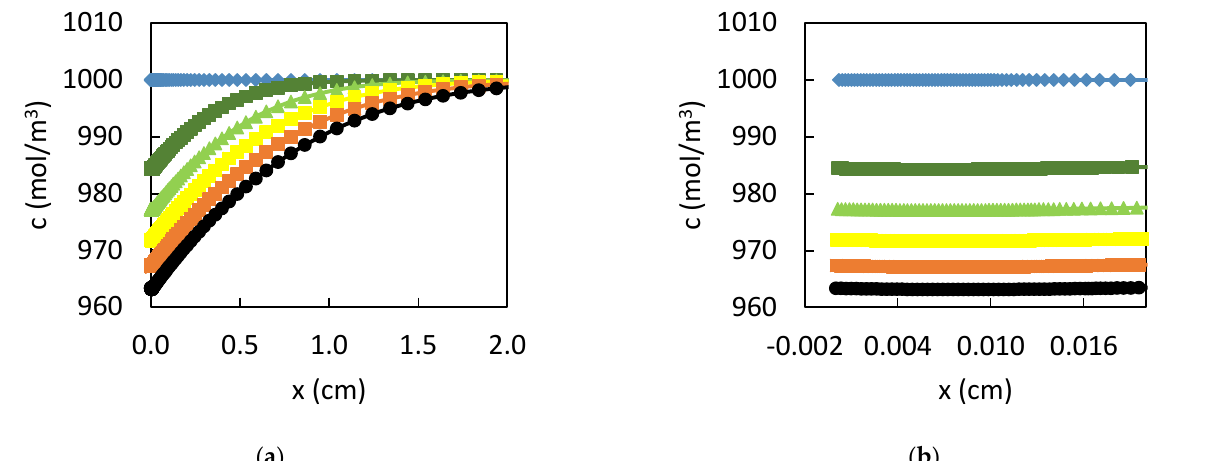
Figure 9. Evolution of the chloride ion concentration in an electrolyte of 1000 mol/m 3 HCl and of size L = 10 cm with an initial CPL of 100 µm and a fixed porosity of 0.9 ( a ) the first 2 cm and ( b ) the first 200 µm of the electrolyte are presented for different times t = 0 s (light blue), 3600 s (dark green) 7200 s (green), 10,800 s (yellow), 14,400 s (orange), and 18,000 s (black).